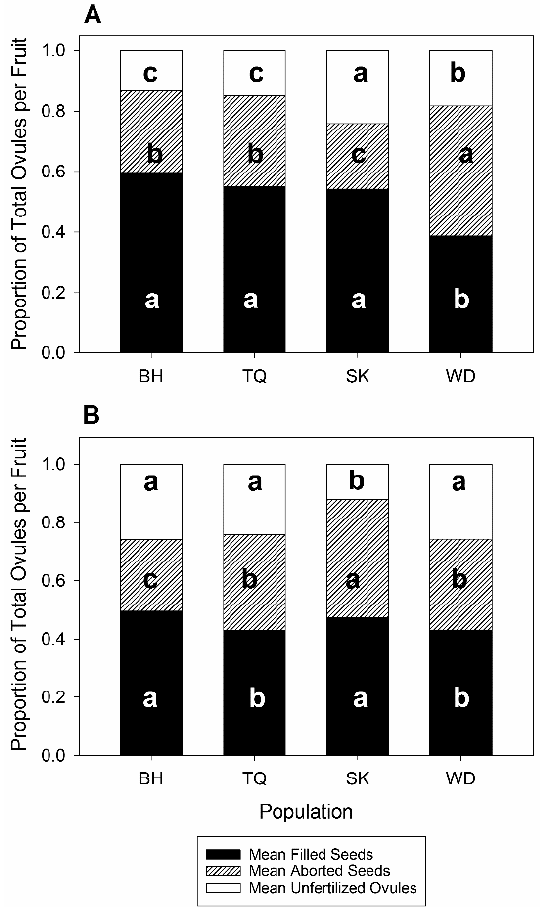
Figure 4. Ovule fates at four populations of dwarf bear poppy in ( A ) 2019 and ( B ) 2020. Within each year and response variable (designated by shading), bar sections with the same letter are not signif- icantly different at p < 0.05. Note that the test for unfertilized ovule proportion is the same as a test for fertilization success. BH = Beehive Dome, TQ = Tonaquint, SK = Shinob Kibe, WD = White Dome. See Appendix B for full statistical analysis.